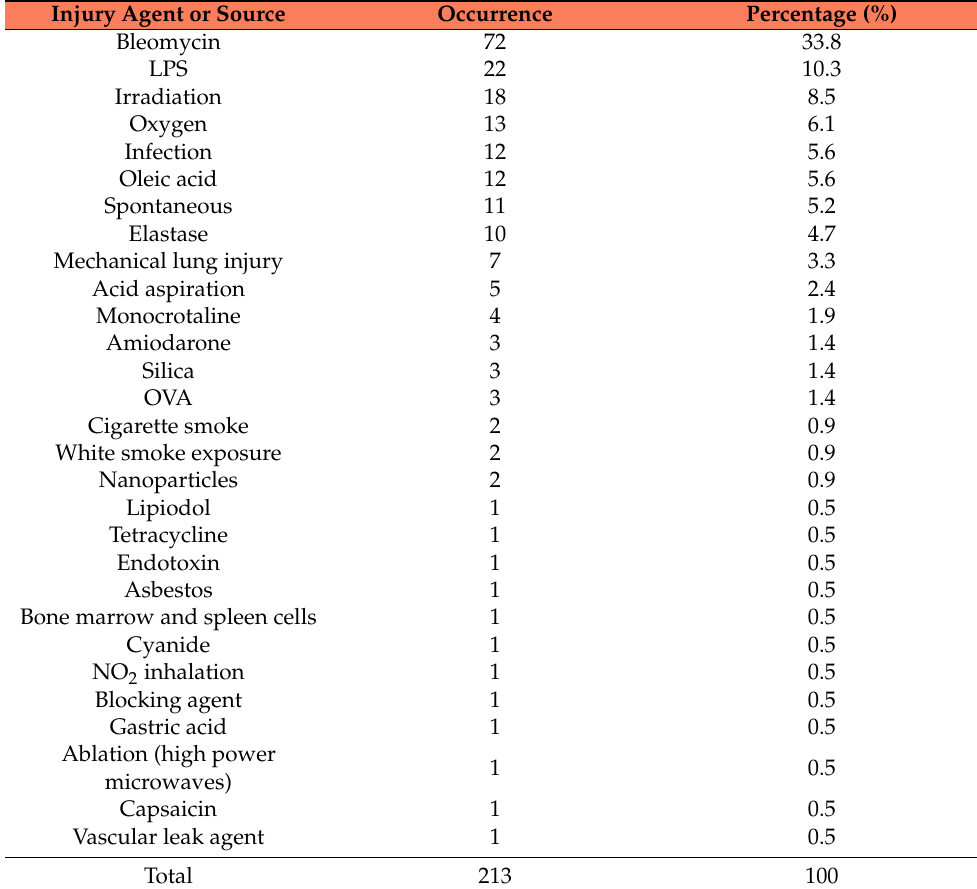
Table 2. Lung injury inducing agents or